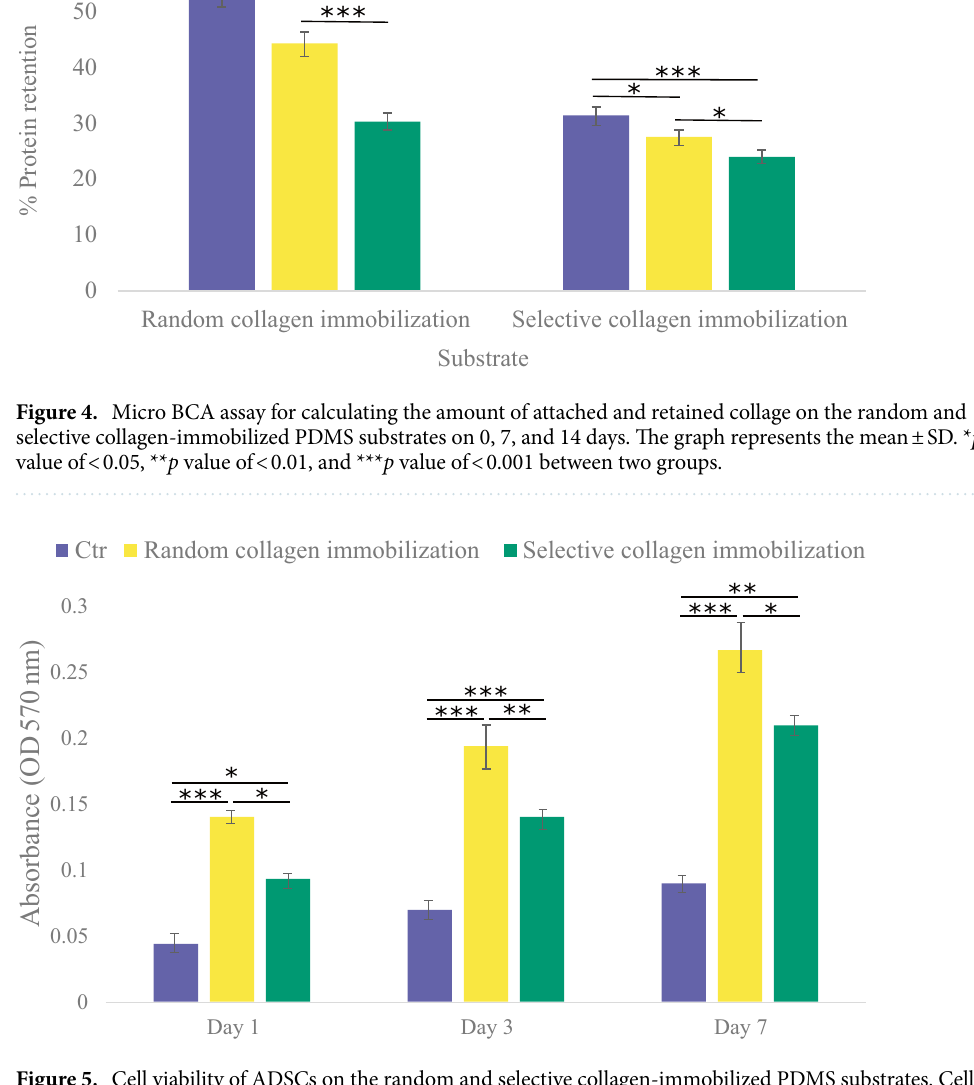
Figure 5. Cell viability of ADSCs on the random and selective collagen-immobilized PDMS substrates. Cell- imprinted PDMS without collagen immobilization was used as a control. The data shows the mean ± SD. * p value of < 0.05, ** p value of < 0.01, and *** p value of < 0.001 between two